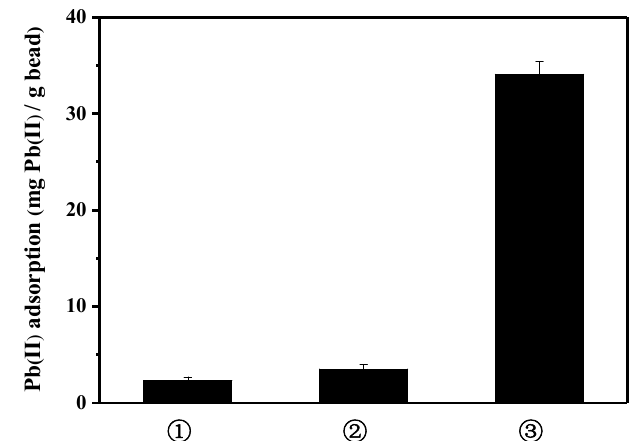
Figure 3. Comparison of lead adsorption capacity: ① bare bead, ② albumin-coated bead, and ③ peptide-linked bead.